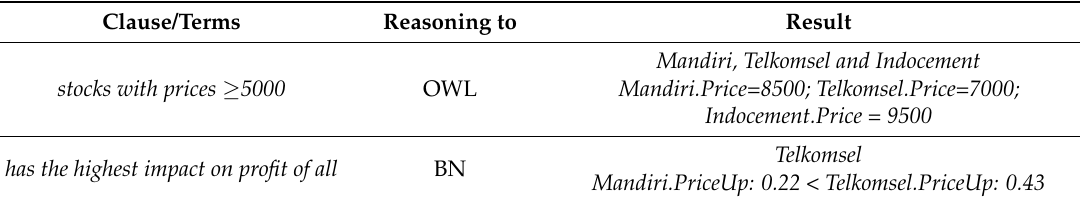
Figure 11 . Investment #2: the structure of classes and individuals in the OWL document. Table 5. Investment #2: determining the query answer using conventional two-step reasoning.